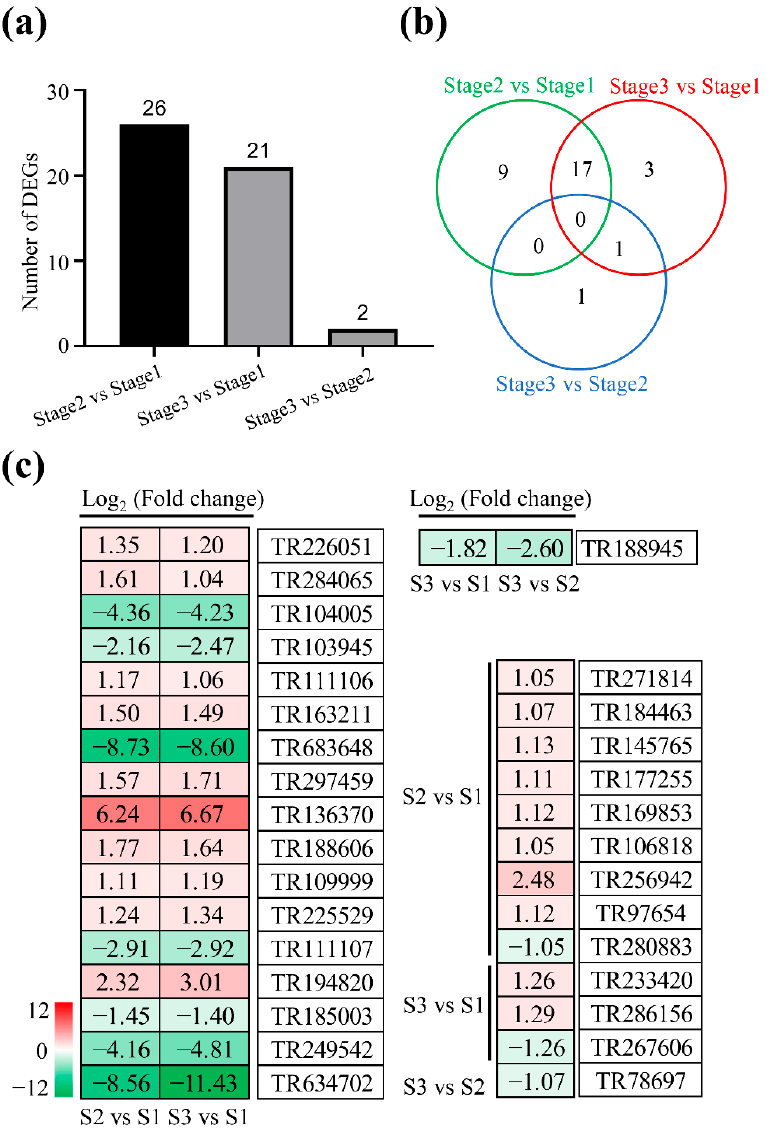
Figure 4. Analysis of differentially expressed genes involved in carbohydrate metabolism. ( a , b ) Summary of differentially expressed genes at stage 1, stage 2, and stage 3. ( c ) The list of differentially expressed genes. Red and green represent up-regulated and down-regulated, respectively.